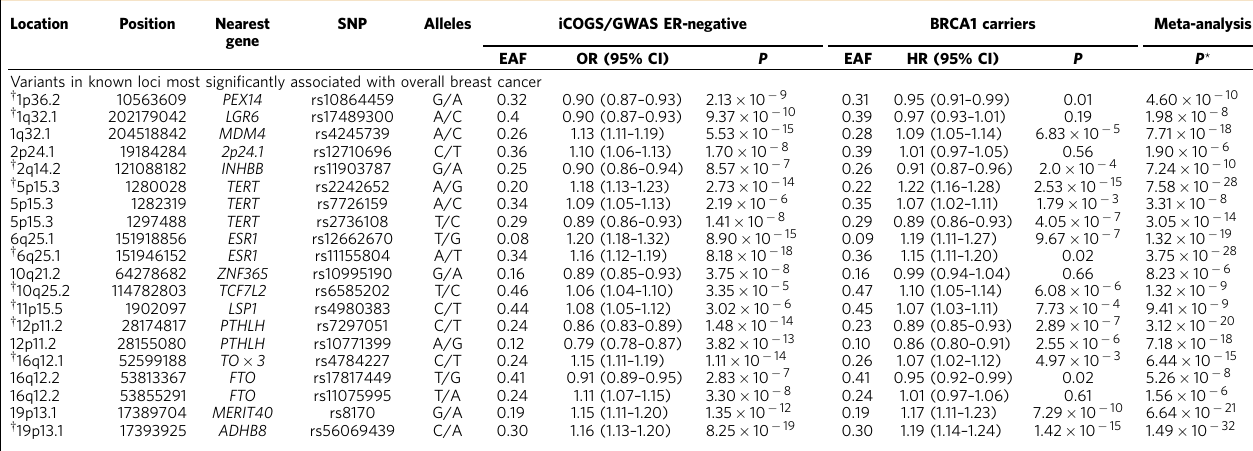
Table 1 | Common genetic variants from known breast cancer susceptibility loci displaying most significant genome-wide associations with ER-negative breast cancer